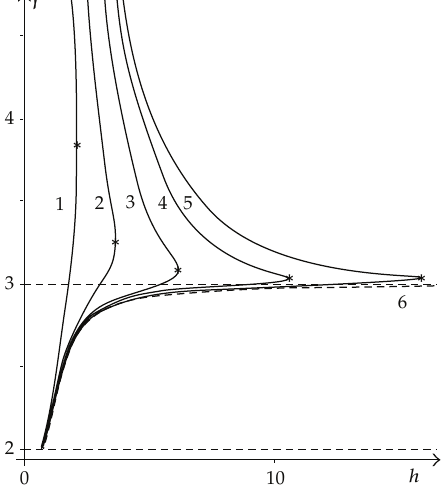
Figure 6: Plot of γ (cid:3) h (cid:4) for the di ff erent values of a : 1 – a (cid:7) 1; 2 – a (cid:7) 0 . 1; 3 – a (cid:7) 0 . 01; 4 – a (cid:7) 0 . 001; 5 – a (cid:7) 0 . 0001; 6 – a (cid:7) 0 (cid:3) linear case (cid:4) . The following parameters are used for both cases: ε 1 (cid:7) 4, ε 2 (cid:7) 9, ε 3 (cid:7) 1, (cid:3) h (cid:4) (cid:7) 1. Dashed lines are described by formulas: γ (cid:7) 2 (cid:3) lower bound for γ (cid:4) , and for the nonlinear case E z γ (cid:7) 3 (cid:3) upper bound for γ in the case of linear medium in the layer (cid:4) . Curves (cid:3) solid (cid:4) 1–5 are solutions of (cid:3) 7.14 (cid:4) , and curve 6 (cid:3) dashed (cid:4) is solutions of (cid:3) 8.1 (cid:4)